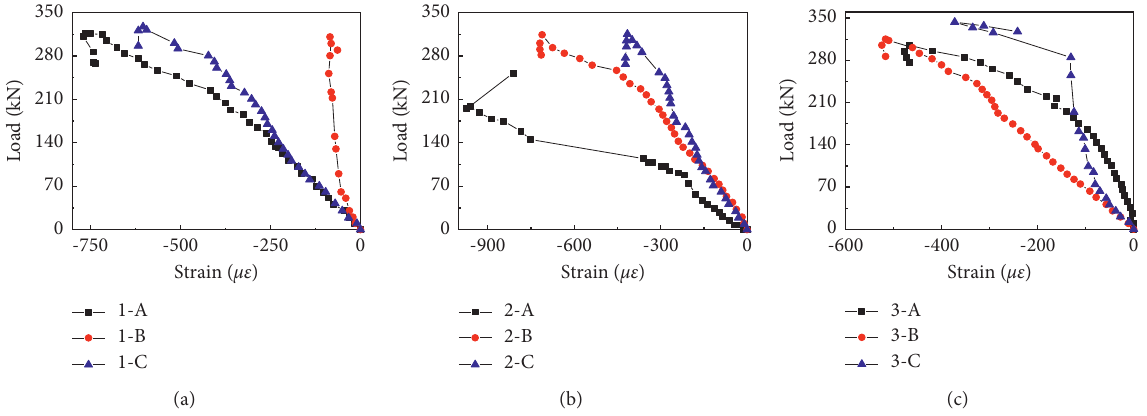
Figure 18: Load-strain curves of No. 47 measuring point. (a) First group. (b) Second group. (c) Third group.